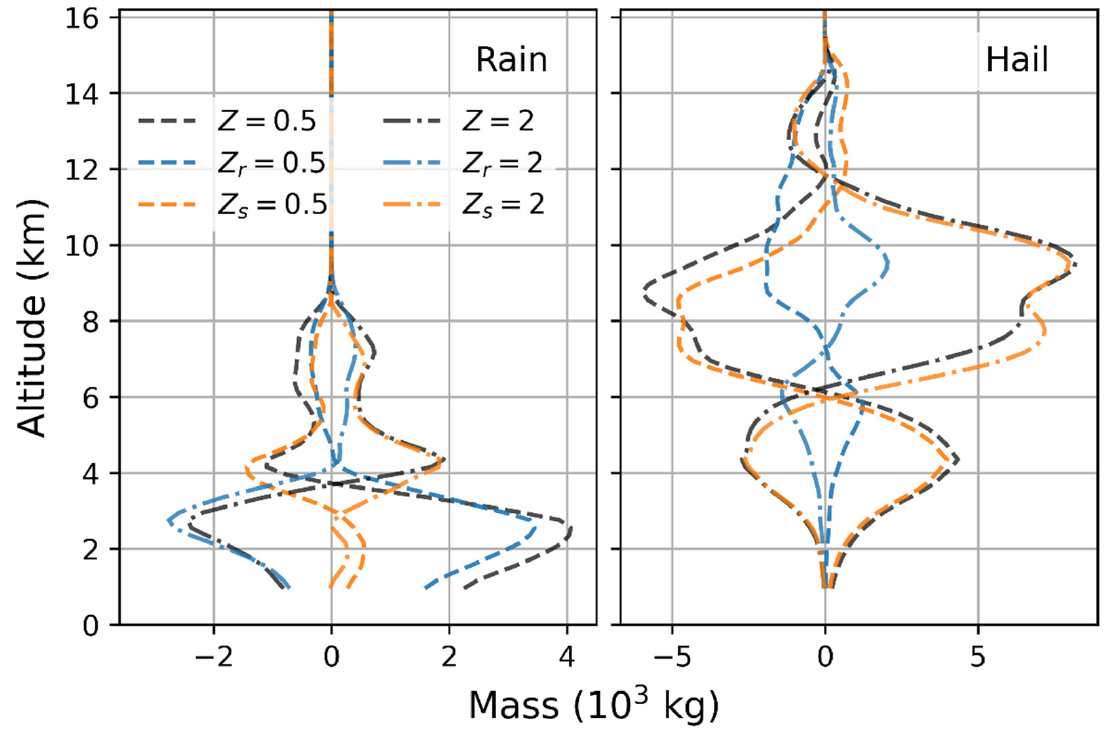
Figure 6. The differences in the averaged mass of rain ( left ) and hail ( right ) from that of the control run in the period from 30 to 70 min as a function of altitude. The colors and styles of curves representing different cases are the same as in Figure 4.